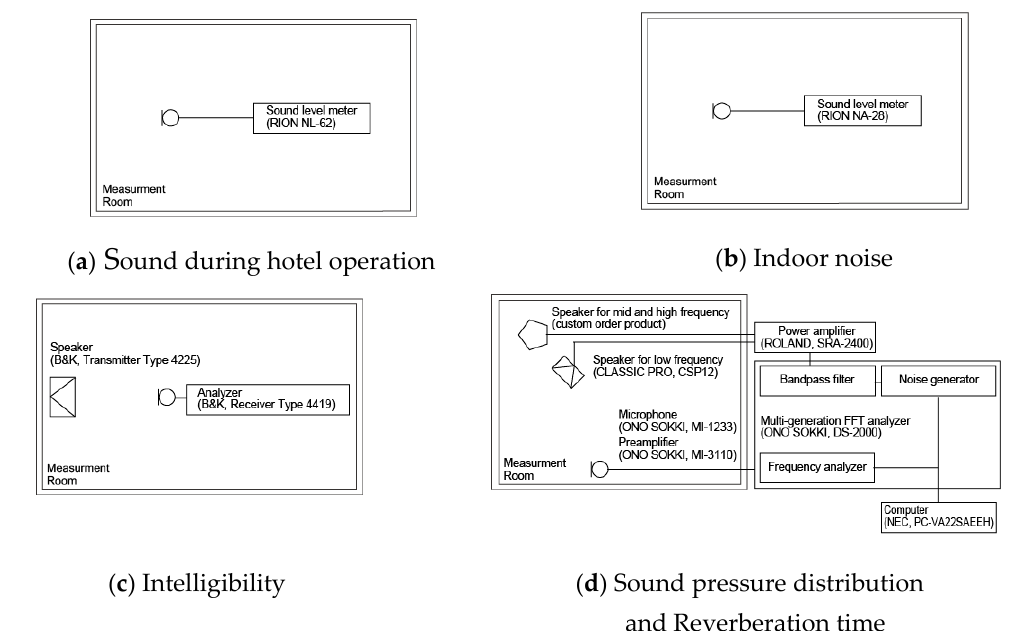
Figure 5. The measurement system block diagrams and the measuring instruments: ( a ) sound during